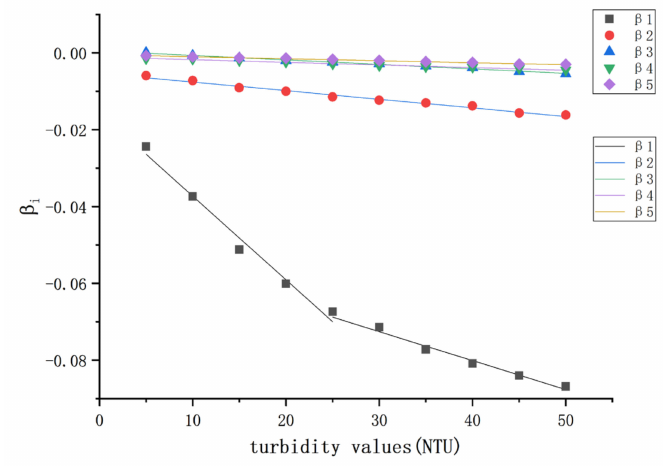
Figure 16. The linear relationship between the turbidity values and β i ( i = 1,2,3,4,5 )